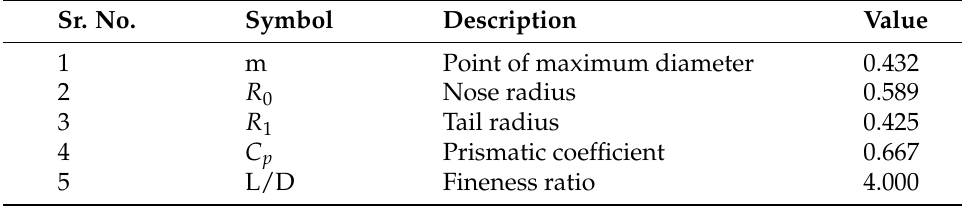
Table 1. Design parameter values for NPL profile (Data from Ref. [47]). Sr. No. Symbol